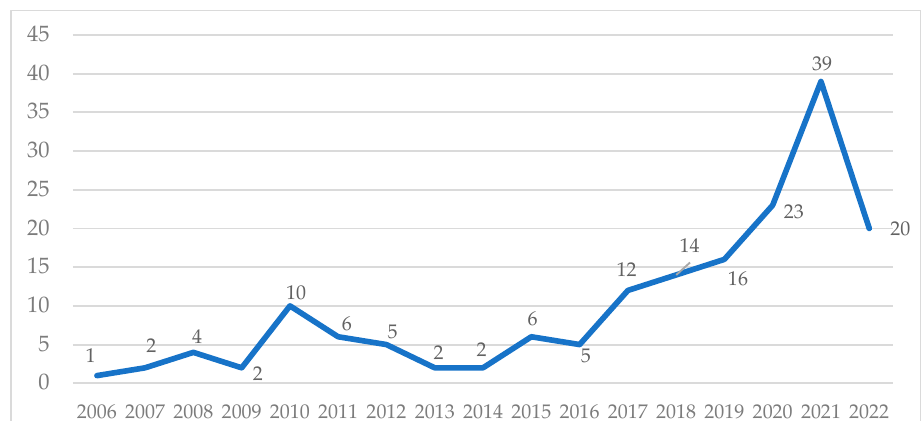
Figure 2. The number of publications per year (until 17 October 2022) (N = 169).